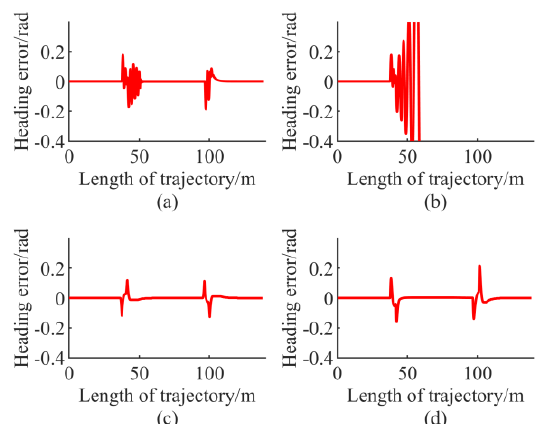
Electronics 2019 , 8 , x FOR PEER REVIEW Figure 11. The heading error when velocity is 3 m / s. ( a ) LMPC. ( b ) LEMPC. ( c ) NMPC. ( d ) NEMPC. Figure 11. The heading error when velocity is 3 m/s. ( a ) LMPC. ( b ) LEMPC. ( c ) NMPC. ( d ) NEMPC.